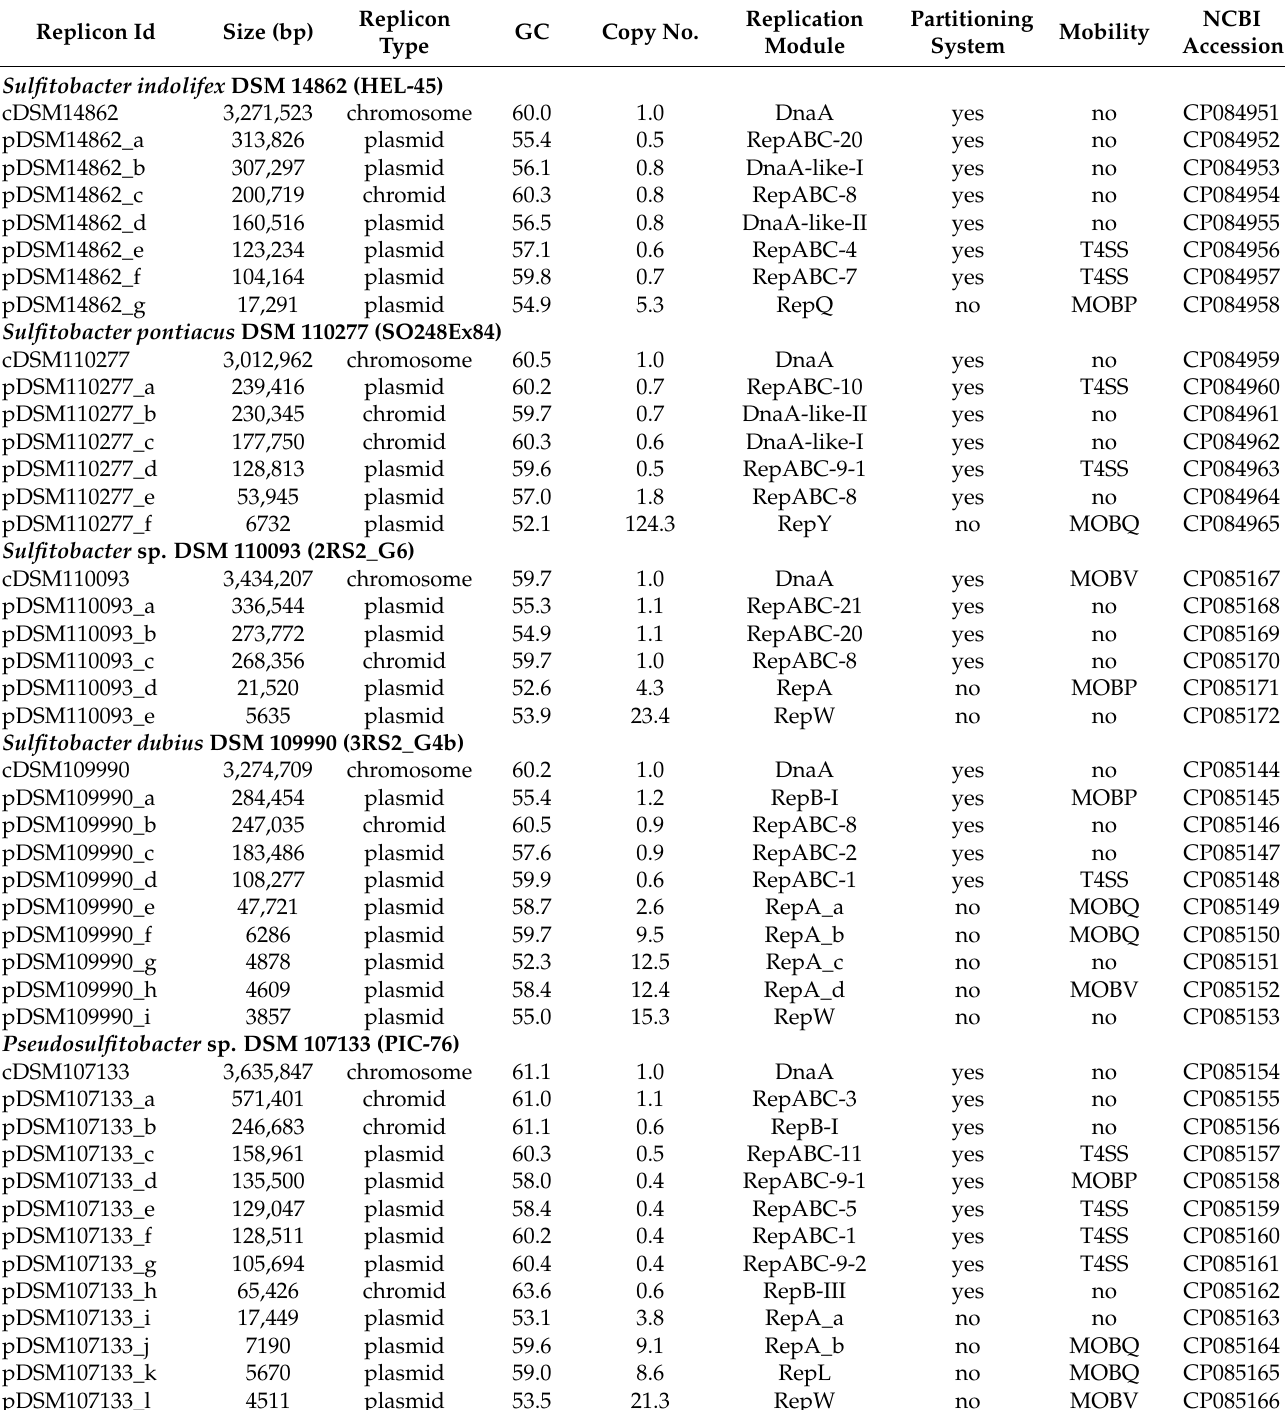
Table 1. Replicon characteristics of investigated ( Pseudo ) sulfitobacter strains with closed